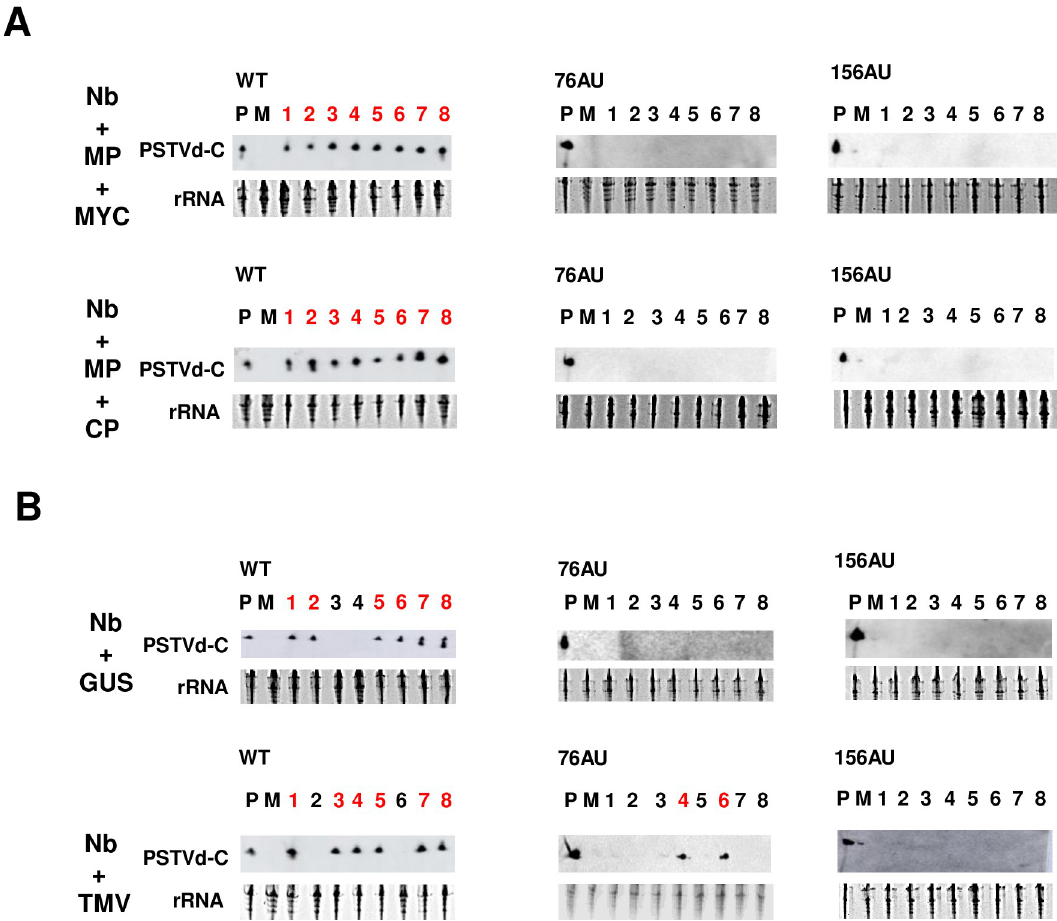
Fig 6. TMV infection, but not TMV MP and CP expression, enables systemic infection of 76AU. (A) In vitro transcripts of WT PSTVd and the 76AU and 156AU mutants were rub-inoculated onto leaves of 2-week-old Nb+MP plants, with 8 plants in each group. TMV CP- and MYC-expressing pCAMBIA1301 vectors were delivered into cells of inoculated leaves twice by agroinfiltration at 5 dpi and 10 dpi. Systemic leaves from Nb+MP+CP and Nb+MP+MYC (negative control) plants were collected at 30 dpi. RNA was isolated and RNA blots performed to detect circular PSTVd RNA. (B) In vitro transcripts representing WT PSTVd and the 76AU, and 156AU mutants were rub-inoculated onto leaves of 2-week-old Nb plants, with 8 plants in each group. TMV- and GUS- expressing pCB301 vectors were delivered into cells of inoculated leaves by agroinoculation at 3 dpi. Systemic leaves were collected from Nb+TMV and Nb+GUS plants at 20 dpi. RNA was isolated and RNA blots performed to detect circular PSTVd RNA. P, positive control, M, mock. Numbers indicate individual plants, with red indicating positive PSTVd signal. Loading control was rRNA.